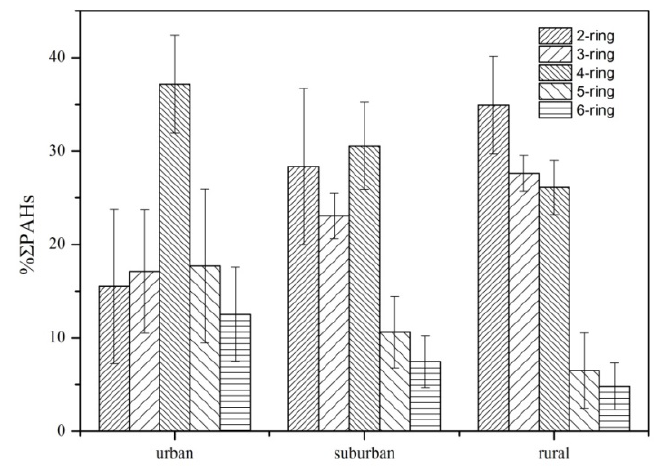
Figure 1. Composition profile of PAHs in forest